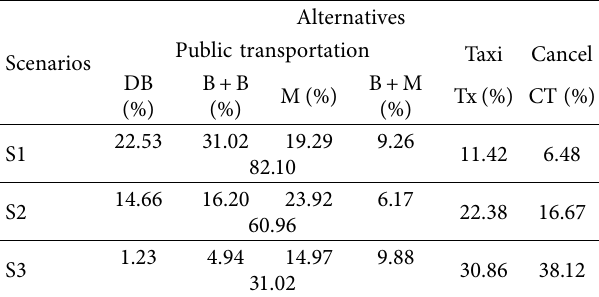
Table 3: Selection of transit commuters in the storm.